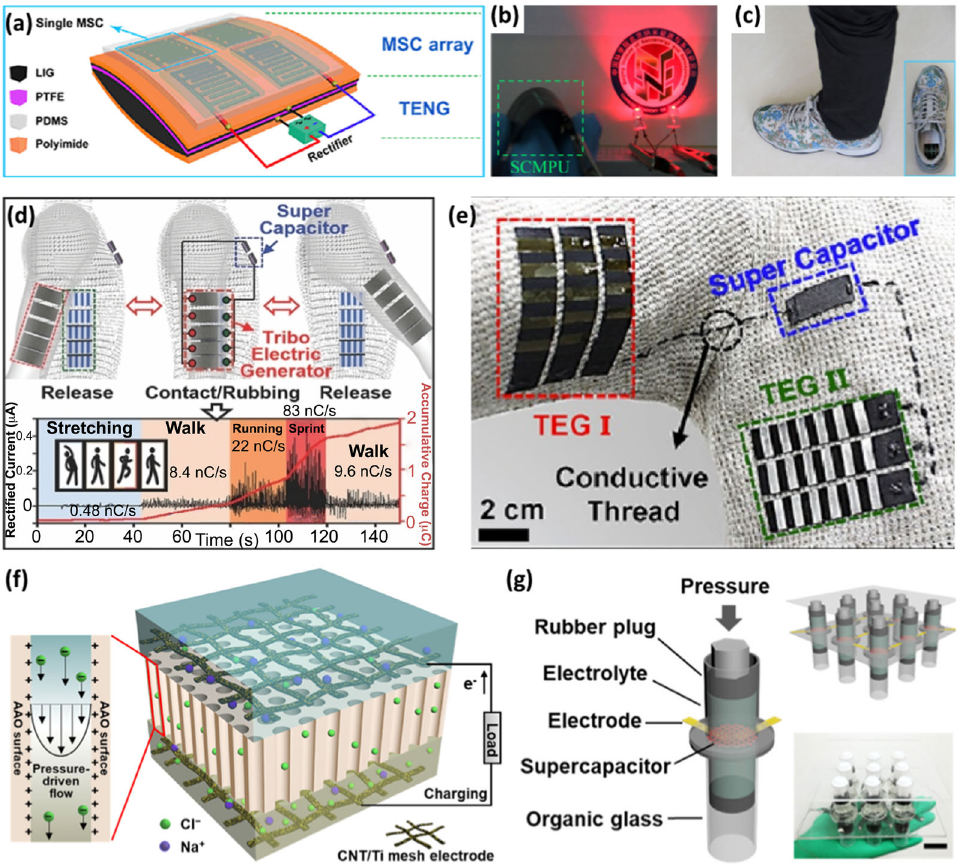
Fig. 10 Self-powered wearable e -skin: self-charging devices. a 3D schema of fl exible SCMPU. Photograph of b bent SCMPU generating enough power to light up LEDs, and c SCMPU inserted in the insole of a shoe. Reprinted with permission from Luo et al. 196 Copyright © 2015, Springer Nature. d Schema showing the charging/discharging mechanism of SC by TENG (top) and SC output under different human activities (bottom). e Photograph of SPP manufactured on fabric, consisting of TENG and SC and integrated on a jersey. Reprinted with permission from Jung et al. 199 Copyright © 2014, John Wiley and Sons. 3D schema of f a single SPP consisting of CNT/Ti electrode and AAO membrane as SC, and PZNG, and g a 3 × 3 array of SPP connected in series. Reprinted with permission from Yang et al. 198 Copyright © 2018, American